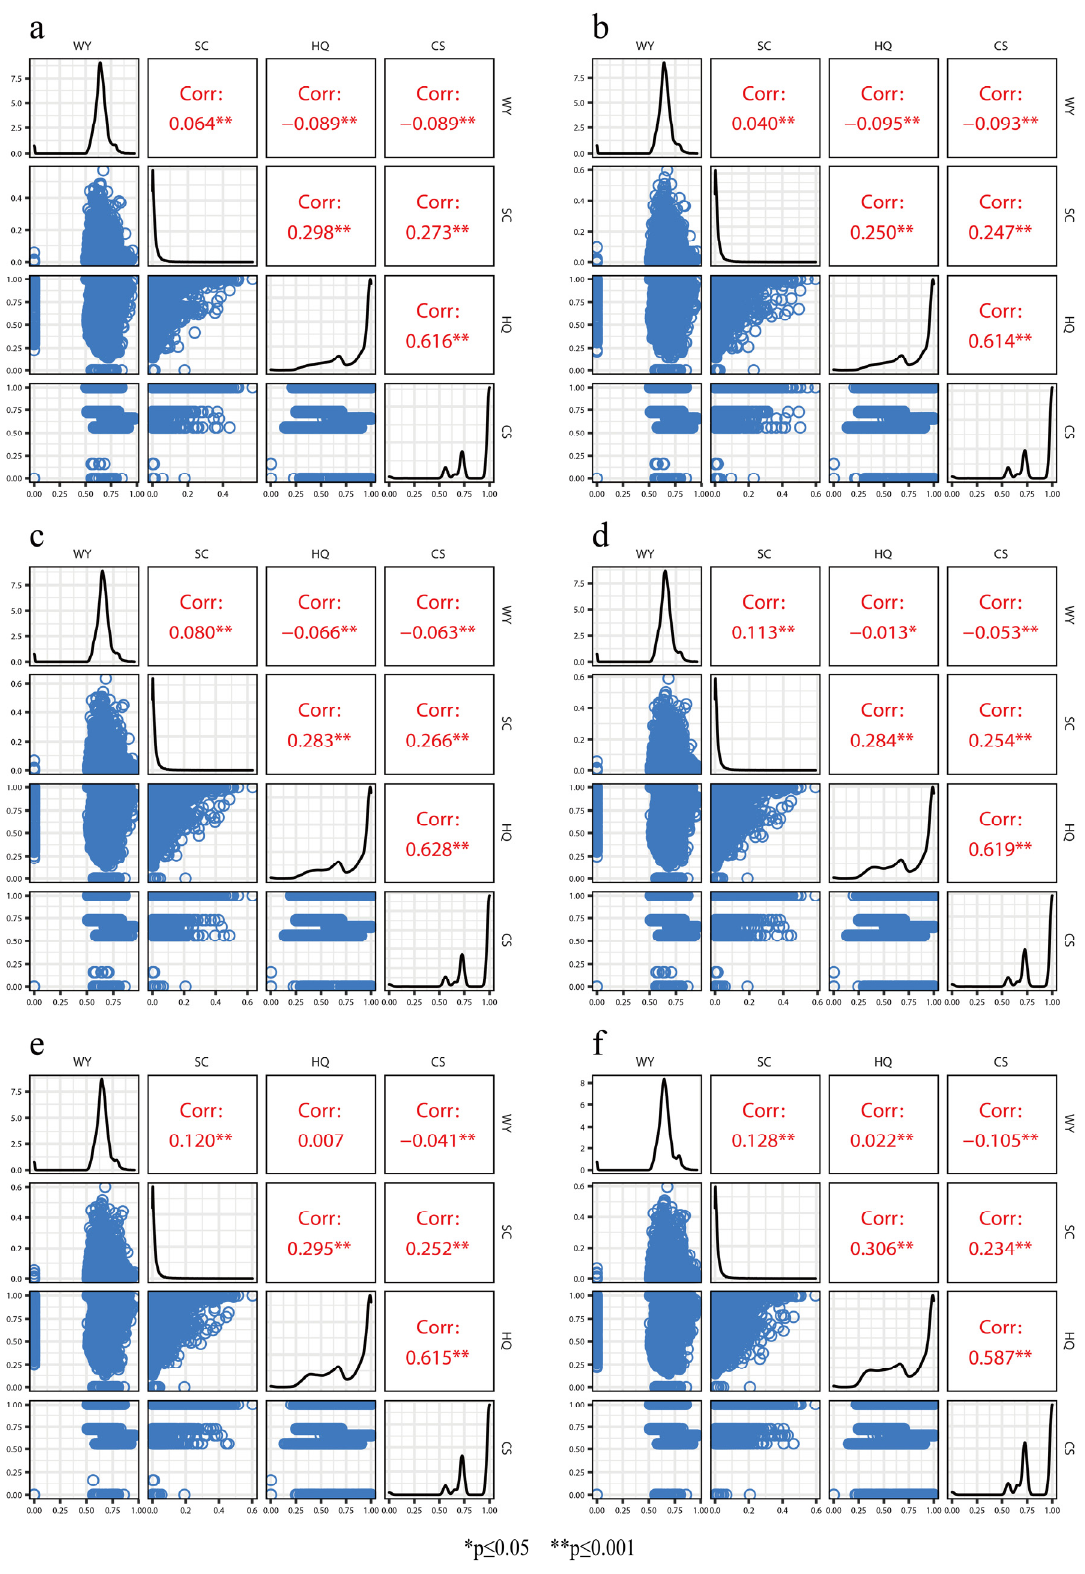
Figure 5. Matrix of ecosystem service relevance coefficients, 2002–2030. Note: ( a ): 2002; ( b ): 2006; ( c ): 2010; ( d ): 2014; ( e ): 2018; ( f ): 2030. HQ and CS were significantly positively correlated from 2002 to 2018 (0.600 < r < 1, p < 0.001), indicating that they have a significant synergistic relationship. Their R-values